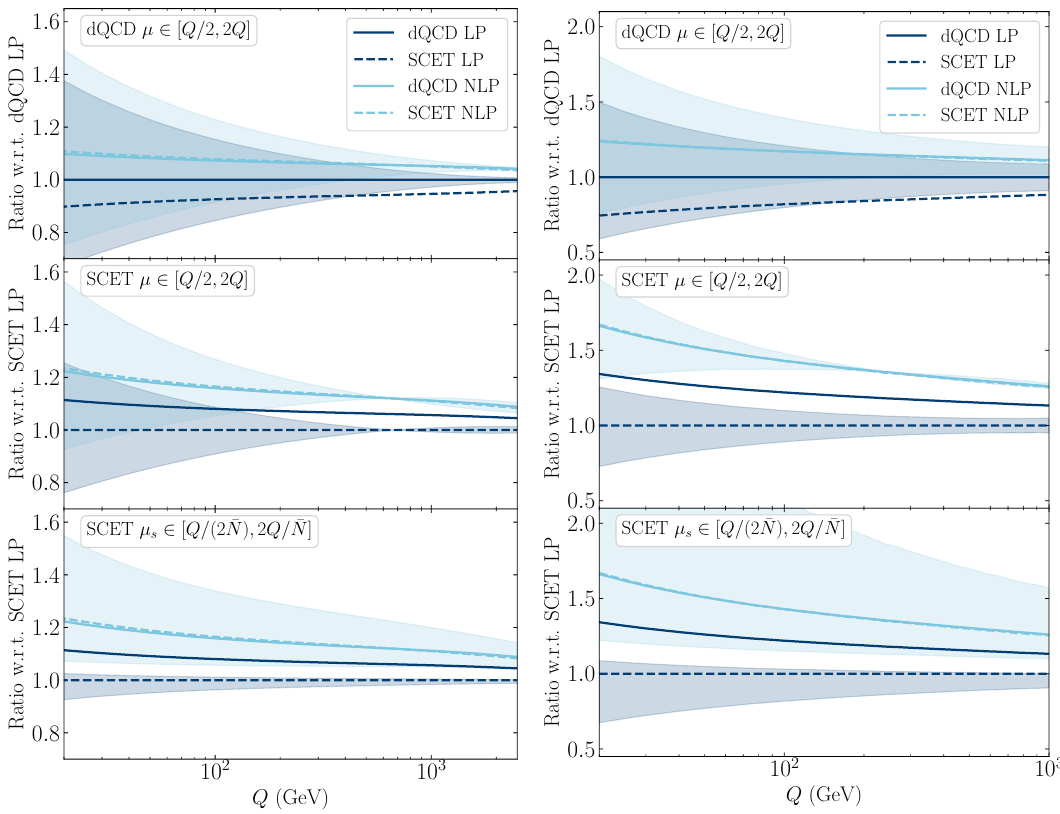
Figure 16. Scale uncertainty of the LP and NLP dQCD and SCET results for DY (left) and Higgs (right). The LP (NLP) results are indicated in dark-blue (light-blue), and the dQCD (SCET) results are shown by the solid (dashed) lines. On the top panel, we normalize to the dQCD LP result showing the dQCD uncertainties obtained by varying µ ∈ [ Q/ 2 , 2 Q ] . The middle panel shows the curves normalized to the SCET LP result and with the scale variation of the SCET results with µ ∈ [ Q/ 2 , 2 Q ] . The bottom panel shows the SCET uncertainty by varying the soft scale µ s ∈ [ Q/ (2 ¯ N ) , 2 Q/ ¯ N ]